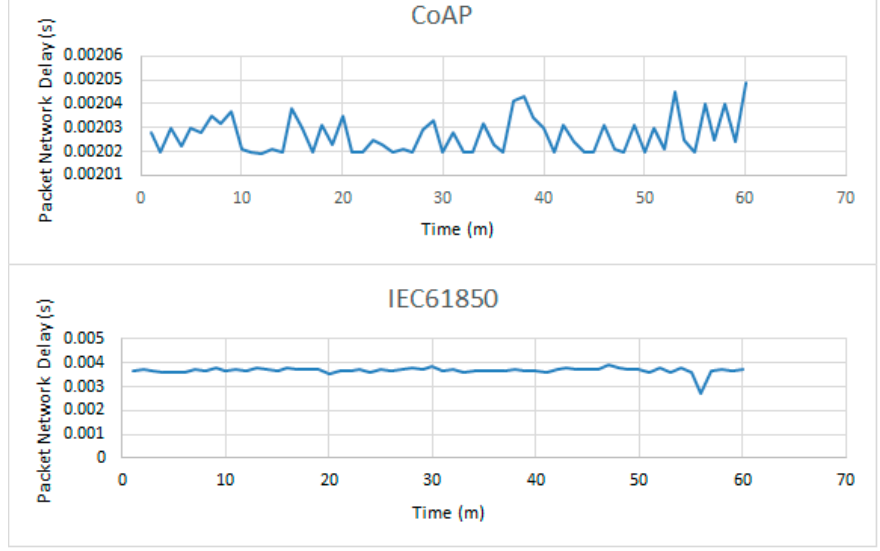
Figure 12. Application packet network